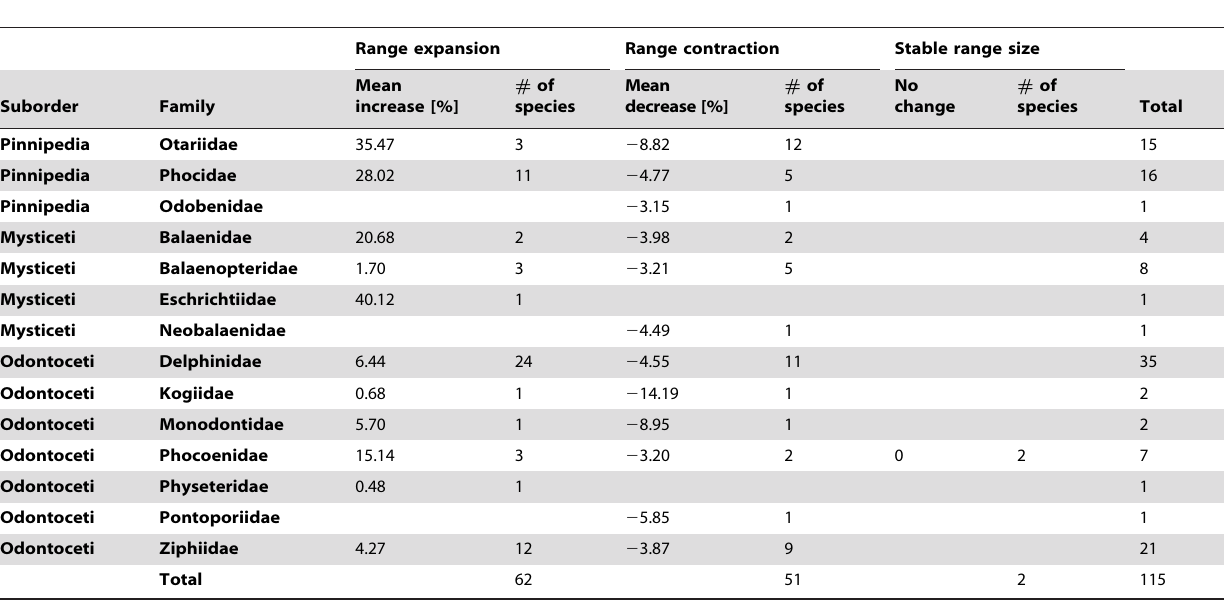
Table 3. Predicted changes in mean size of optimal ranges due to climate change by the years 2040–49 across different taxa (IPCC-A1B scenario & RES .